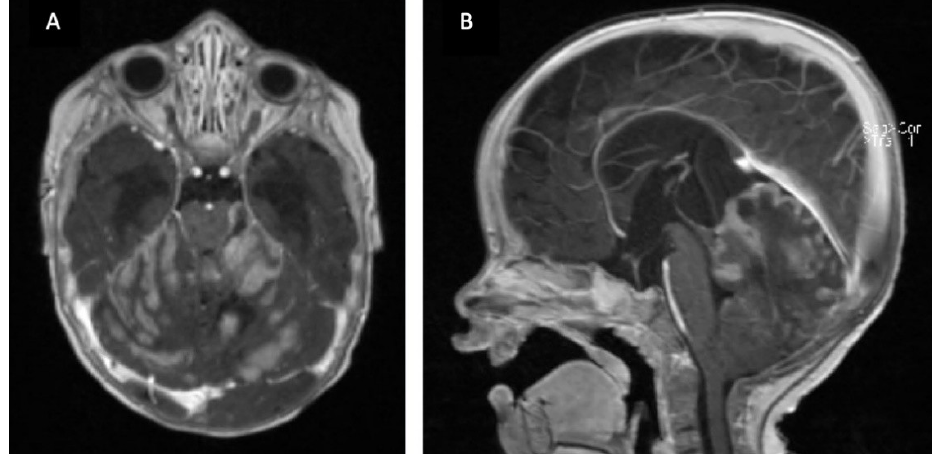
Figure 1. 6 month old boy with macrocephaly and developmental delay. Contrasted T1 MRI (A,B) with large cerebellar tumor and associated hydrocephalus. Diagnosis: SHH-medulloblastoma with extensive nodularity (MBEN) WHO grade 4. Gorlin syndrome (SUFU mutation).